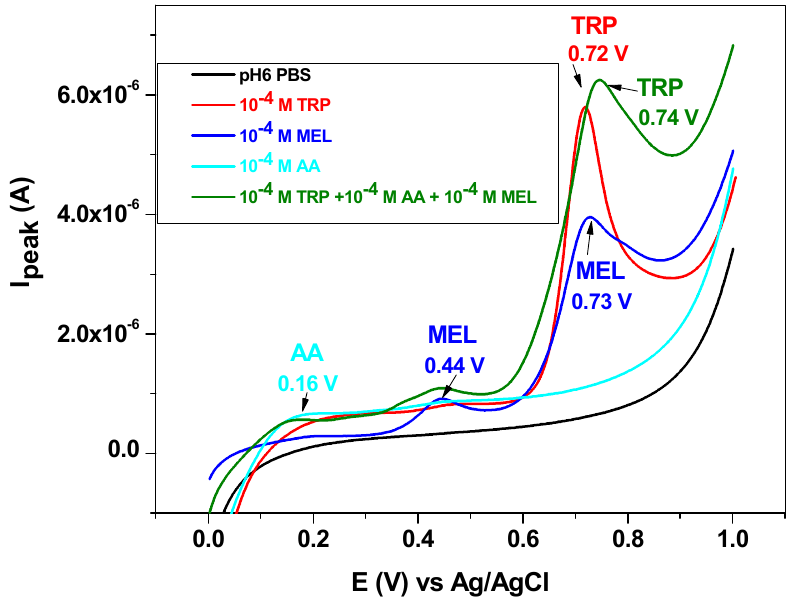
Figure 11. LSV recorded with the EGr/GC electrode in the absence and presence of interfering species, melatonin, and ascorbic acid. Scan rate: 10 mV/s; supporting electrolyte: pH 6 PBS.